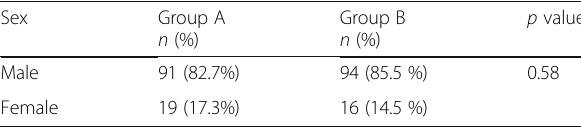
Table 1 Gender distribution in study groups